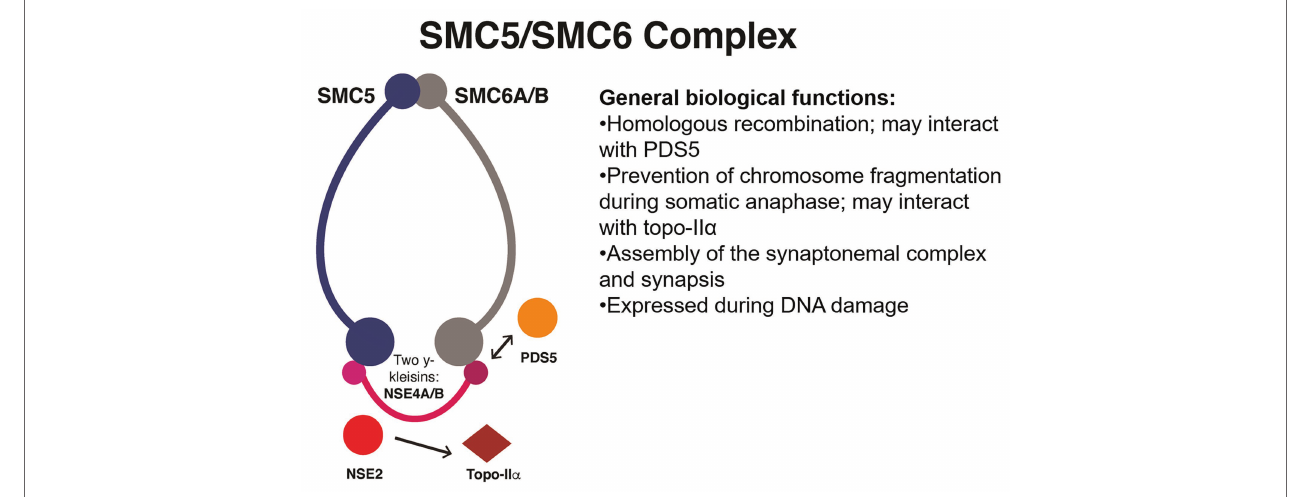
FIGURE 2 | Simplified functional interaction network of the SMC5/SMC6 complex in genome maintenance, homologous recombination, and meiosis. These SMC complexes interact with PDS5 during homologous recombination and have an especially important role during meiotic synapsis as well as somatic chromosome segregation. These complexes may also be required for proper somatic DNA repair via the SUMOylation of topoisomerase II α by associated protein NSE2. NSE proteins have a wide variety of functions that affect pollen development and homologous DNA repair. Topo-II α , topoisomerase-II α